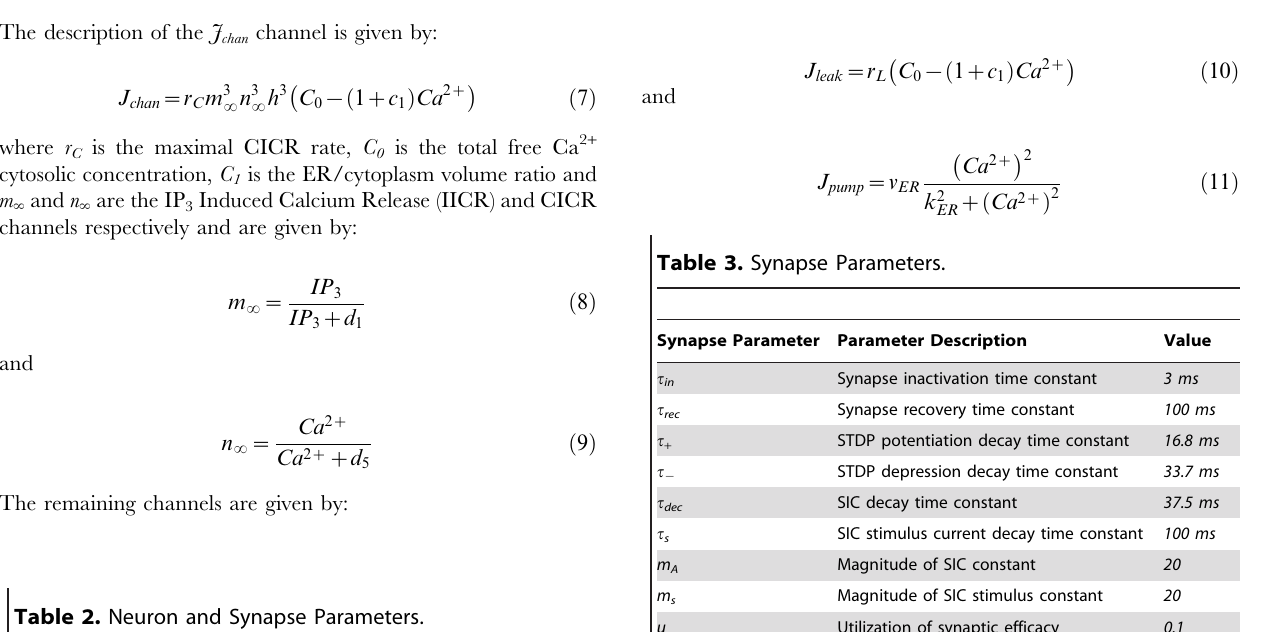
Figure 2. AN Model Block Diagram showing interactions between an astrocyte and neuron cell.